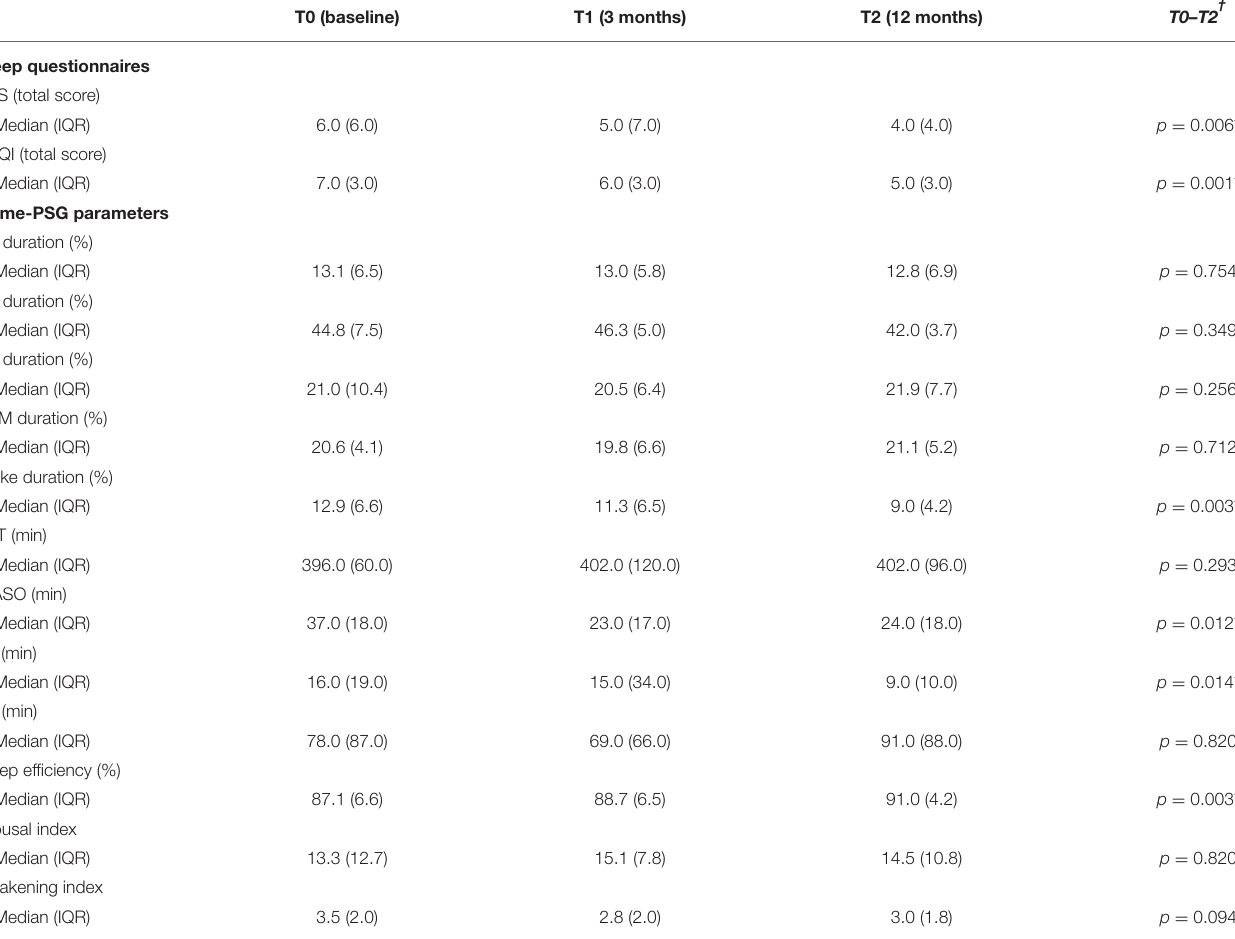
TABLE 6 | Results of sleep questionnaires and home-polysomnography recordings at baseline and after 12 months of treatment with erenumab ( n =